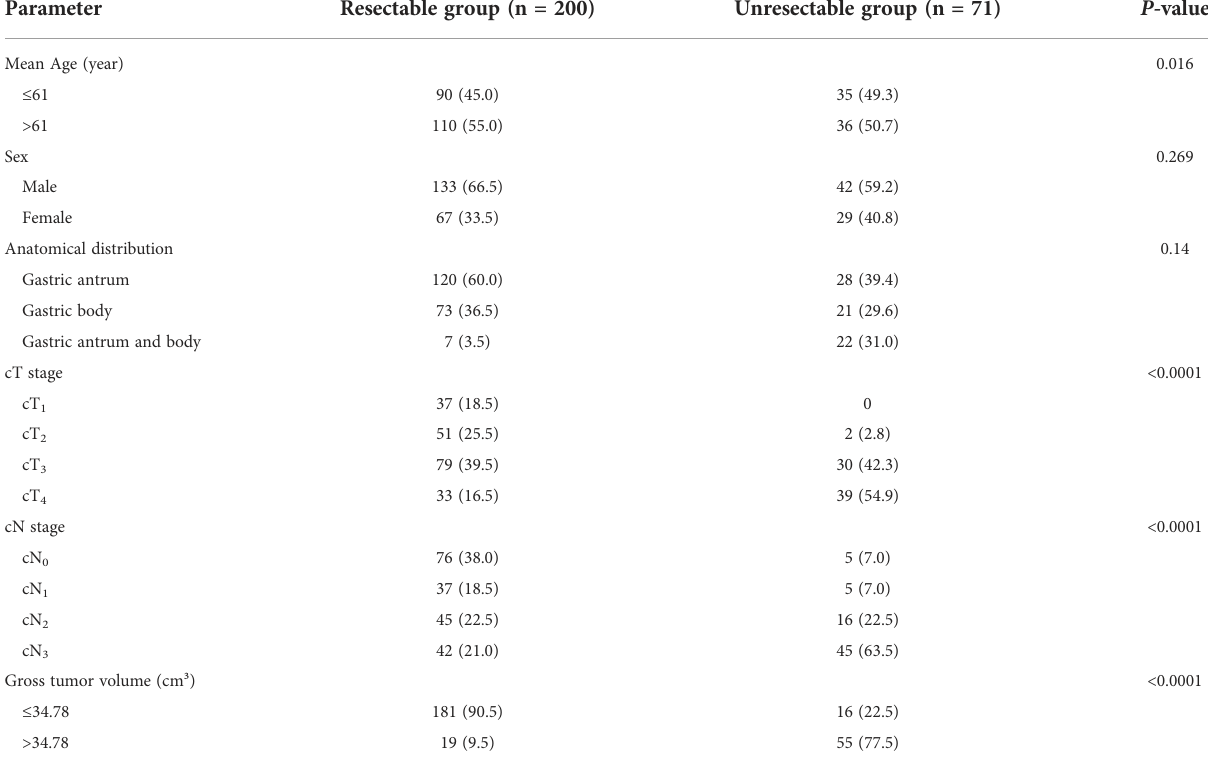
TABLE 2 Univariate analysis of clinicopathological factors and gross tumor volume correlated with resectability of gastric adenocarcinoma in the training cohort.